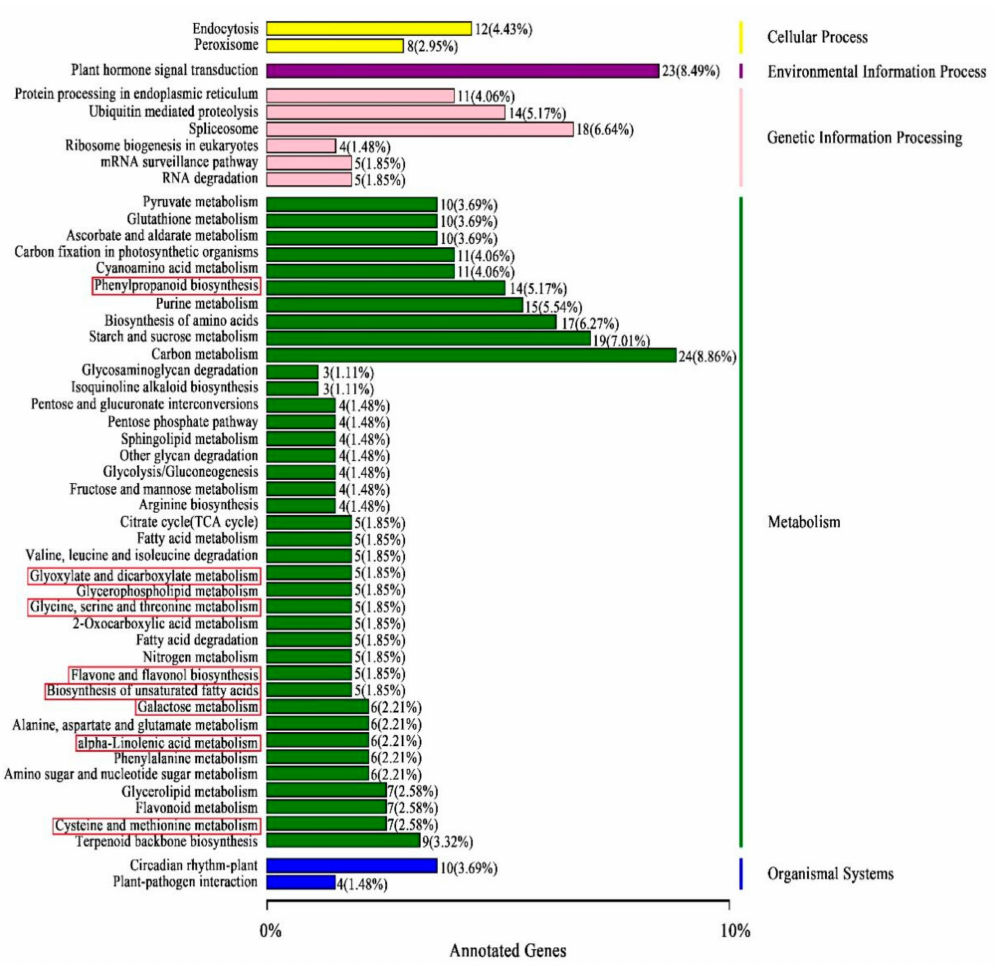
Figure 5. KEGG pathway analyses of DEGs showing the first 50 pathways. Red square box: common pathways between DAM- and DEG-annotated KEGG path- ways. Number and percentage: the number of the DEGs annotated to each KEGG pathway and (the number of the DEGs annotated to each KEGG pathway: the number of all DEGs annotated to all KEGG pathways) ×